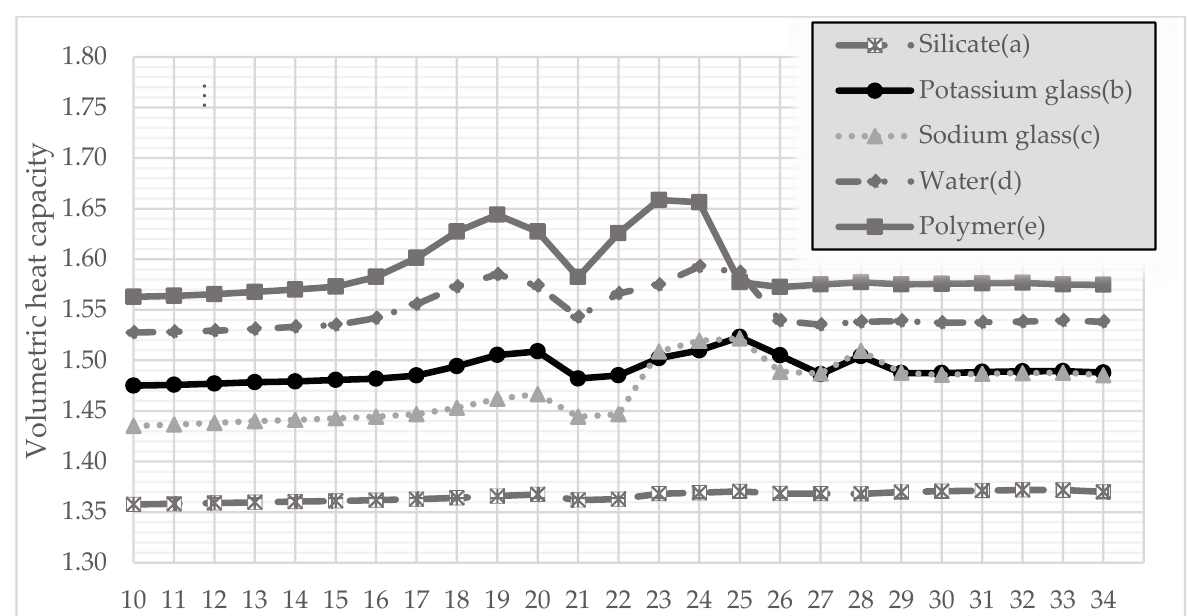
Figure 7. Volumetric heat capacity for coated granules: (a) silicate; (b) potassium glass; (c) soda glass; (d) water; and (e) polymer as a function of temperature.